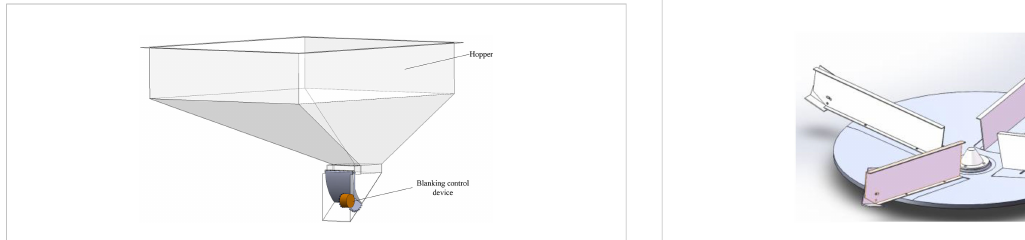
FIGURE 3 Conical seeding